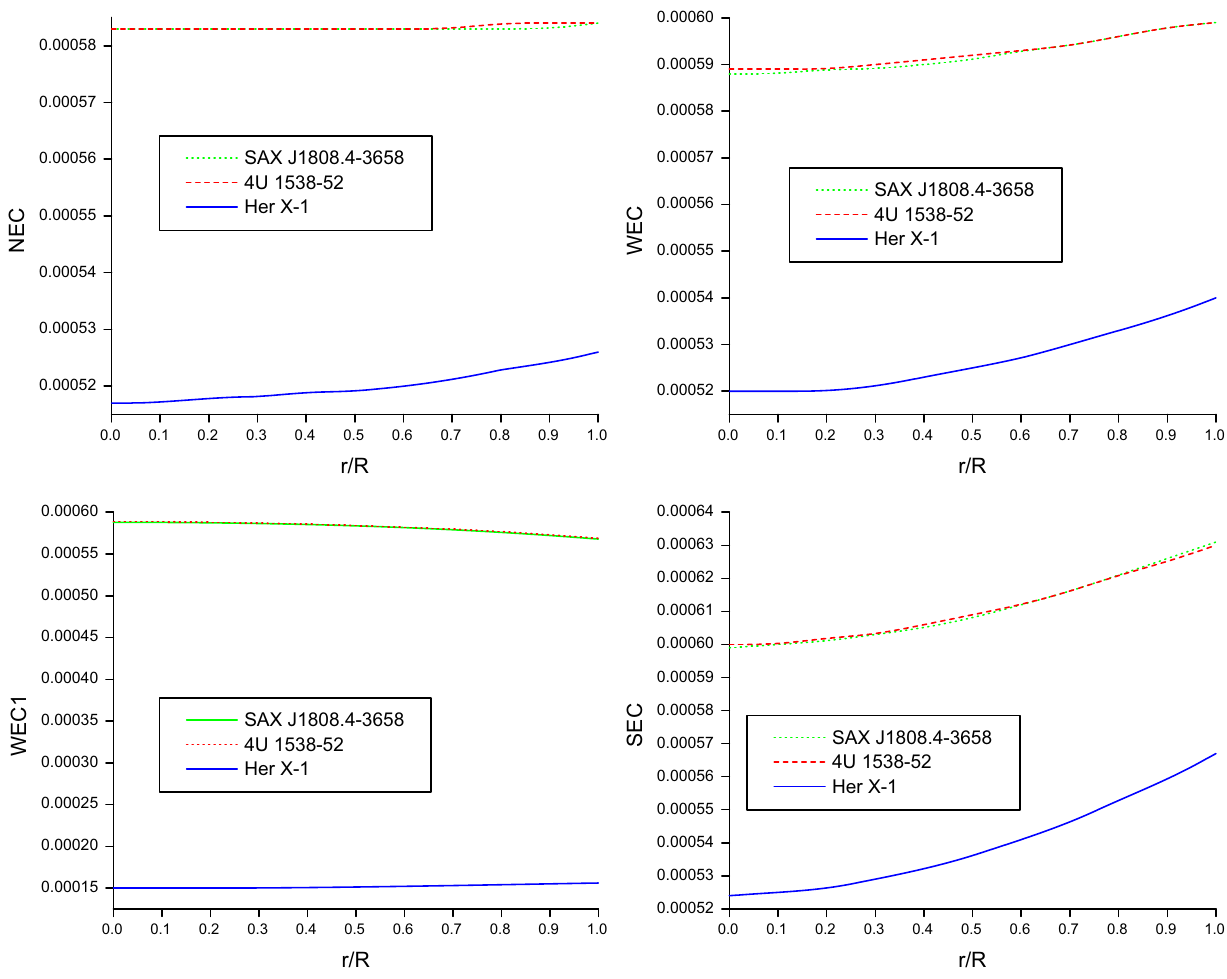
Fig. 4 Curves are plotted for the NEC, WEC, and SEC for the compact objects SAX J1808.4-3658, 4U 1538-52 and Her X-1. For the purposes of this calculation, we use the same values as given in Fig. 1